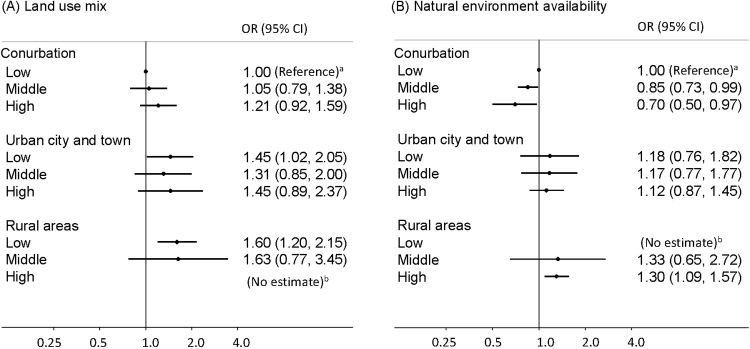
OR of cognitive impairment by interaction terms between land use mix, natural environment availability and rural/urban categories (estimates adjusted for age, gender, education, and chronic conditions).aReference group.bEstimates were not available due to small sample sizes.